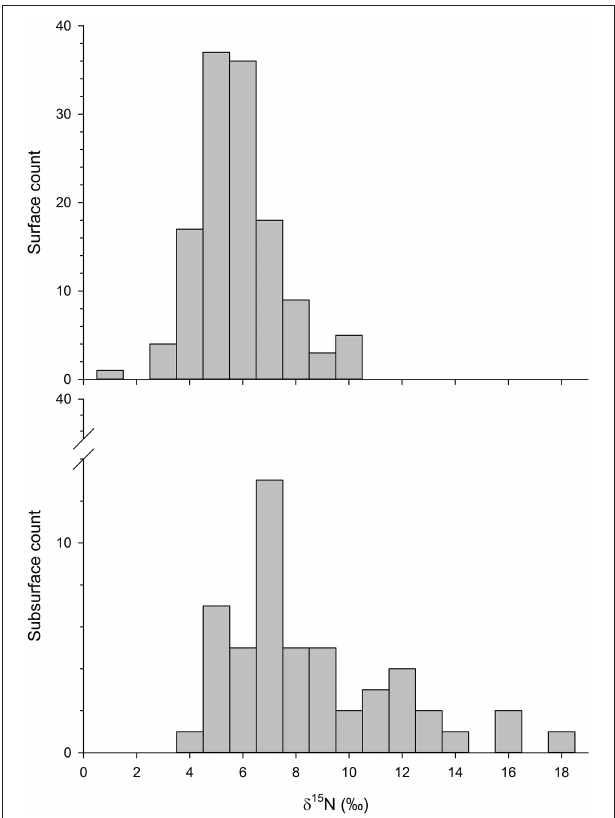
FIGURE 2 | Histogram of surface and subsurface δ 15 N values from the Phase II dataset where the (top panel) shows the count of surface values and the (bottom panel) displays the count of measured subsurface δ 15 N values. Subsurface samples were collected at the bottom of the water column, or as far as the sampling cable would allow. Depths ranged from 17 to 508m below the